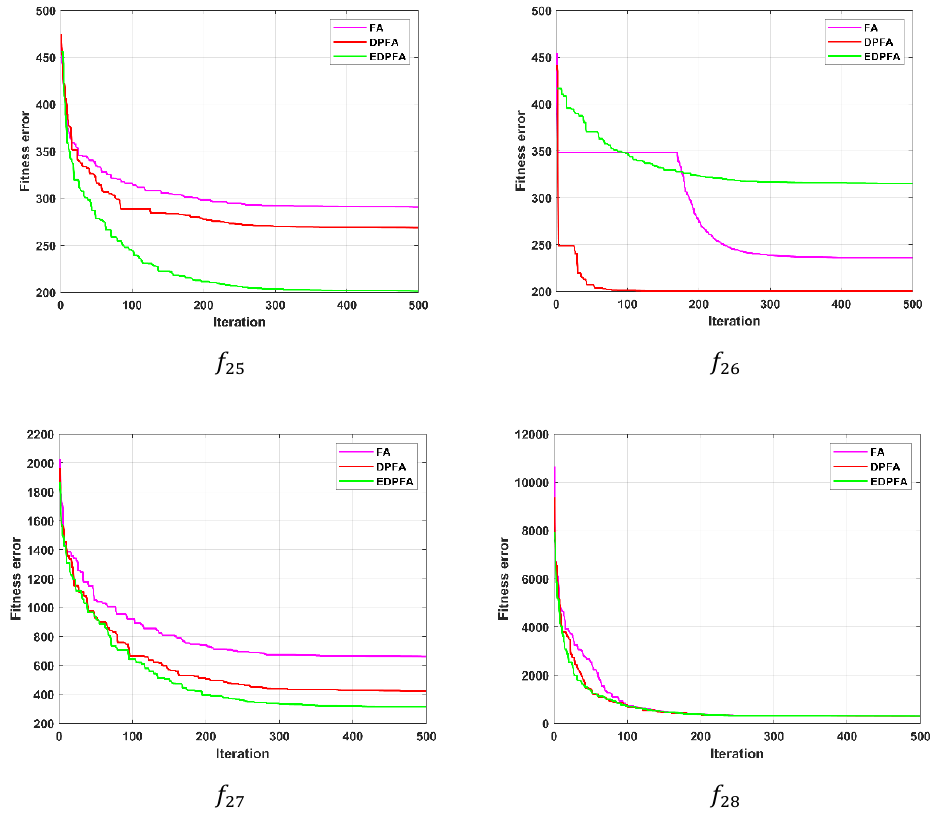
Figure 4. Convergence curves of the FA, DPFA and EDPFA. Table 4. The summary of the convergence speed comparison of the FA, PCFA and DPCFA.